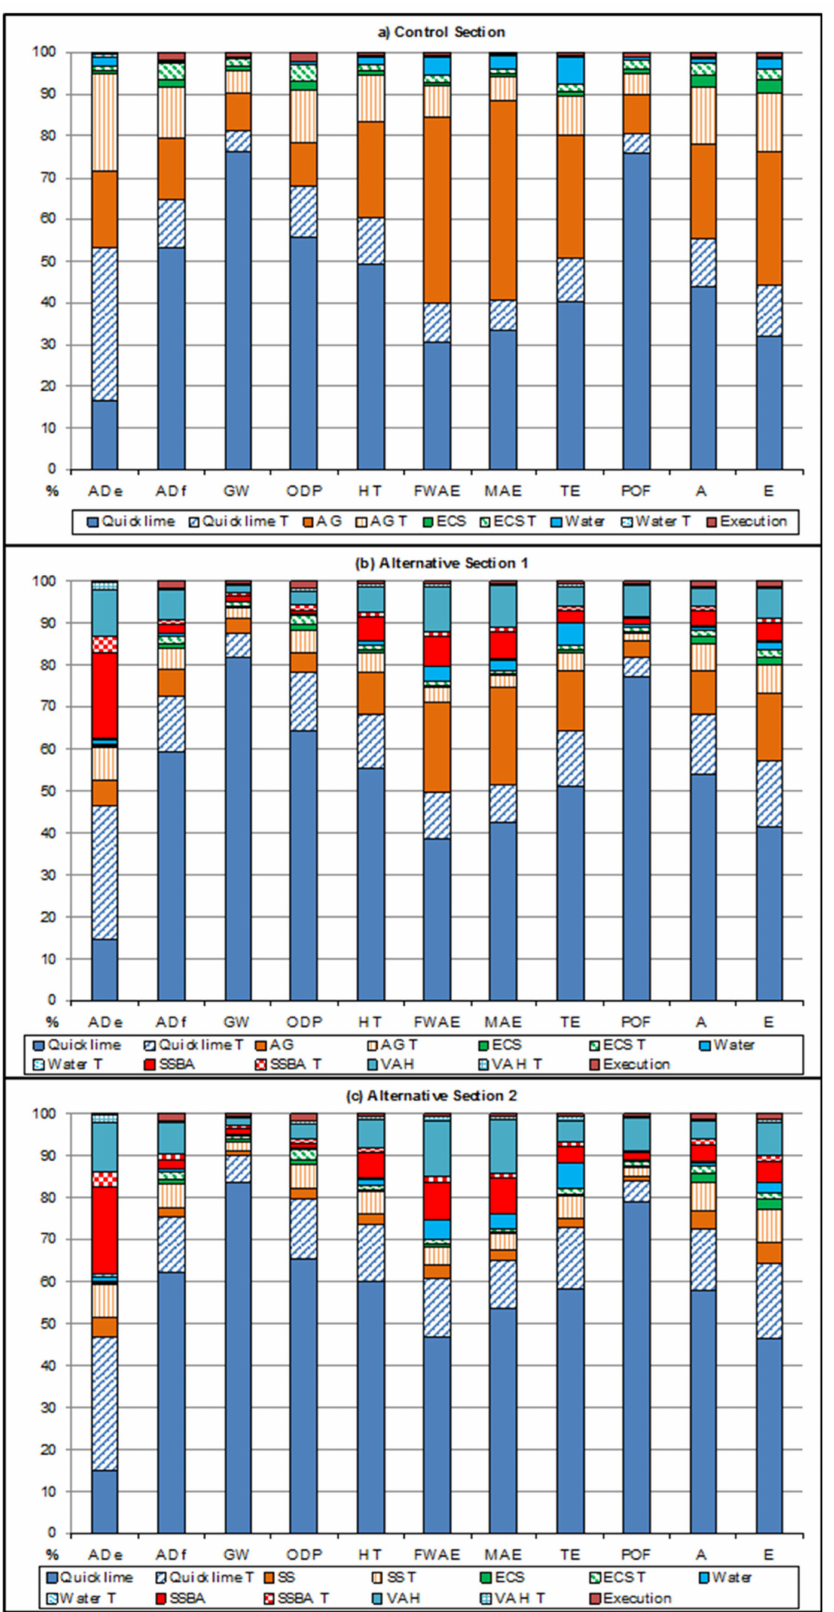
Figure 14. Contribution to the impact by processes: ( a ) Control Section; ( b ) Alternative section 1; ( c ) Alternative section